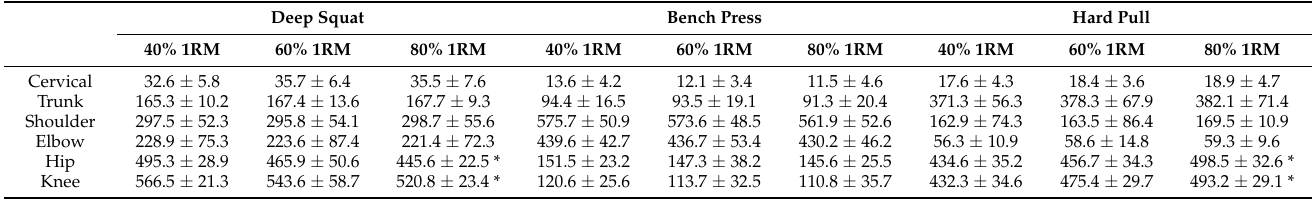
Table 4. Comparisons of peak stress in different load strength tests (N).